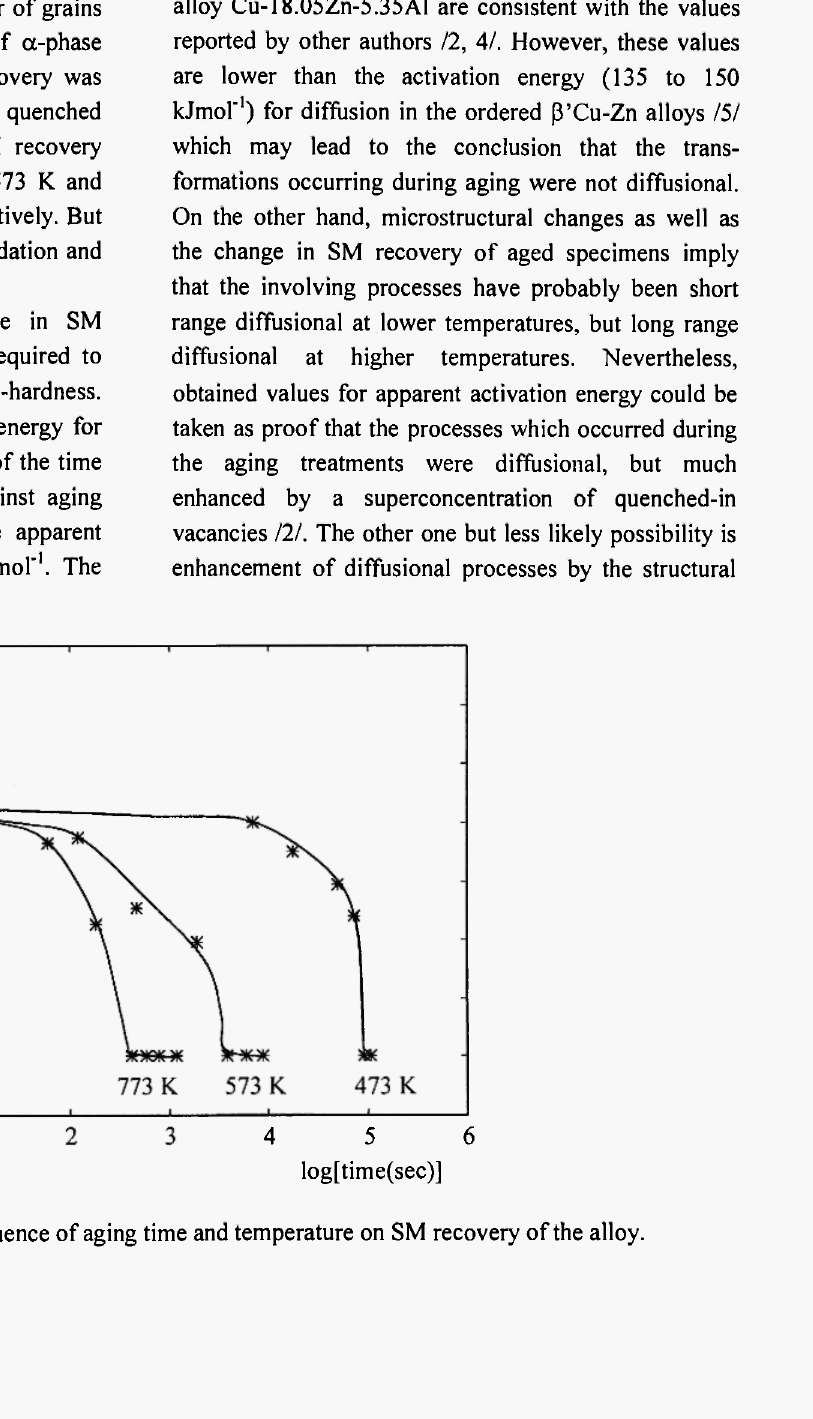
Fig. 11 : Diagram showing the influence of aging time and temperature on SM recovery of the